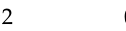
Table 3. Fiber mix ratio. BF: basalt fiber, LF: lignin fiber.